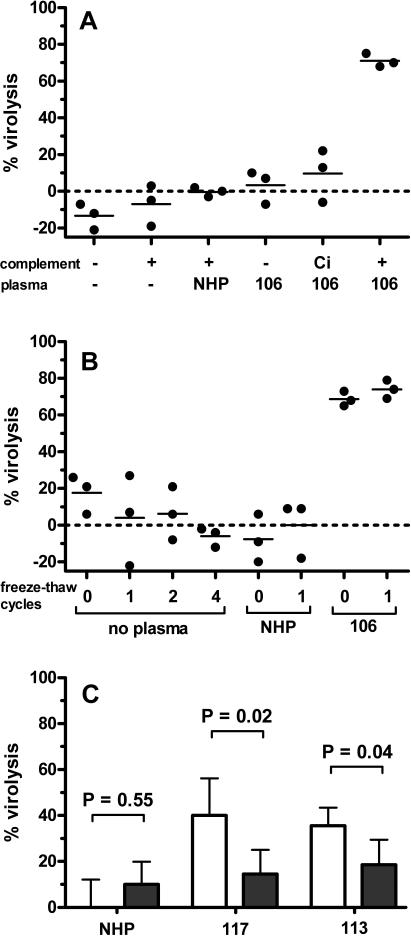
Virolysis by Antibody and Complement(A) Plasma from HIV-positive individuals specifically lyses HIV in presence of active complement. Virus isolate JR-FL was incubated with complement (+), without complement (−), or with inactivated complement (Ci) either in the absence of plasma (−) or with plasma from uninfected individuals (NHP) or from patient 106. One of three independent experiments is shown.(B) Up to four freeze-thaw cycles do not destroy intact HIV-1 virions. Virus JR-FL was incubated in the presence of active complement with medium (no plasma), with plasma from uninfected persons (NHP), or with plasma from patient 106. Reaction mixtures were subjected to the indicated number of freeze-thaw cycles and the effect on virus disintegration was measured. One of two independent experiments is shown.(C) IgG depletion reduces lysis activity. Plasma of uninfected individuals (NHP) and of patients 117 and 113 were depleted of IgG with Protein G Sepharose beads (darkened bars) and lysis activity was compared to untreated plasma (open bars). Error bars indicate standard deviation of triplicate measurements. Groups were compared using Mann-Whitney U test.